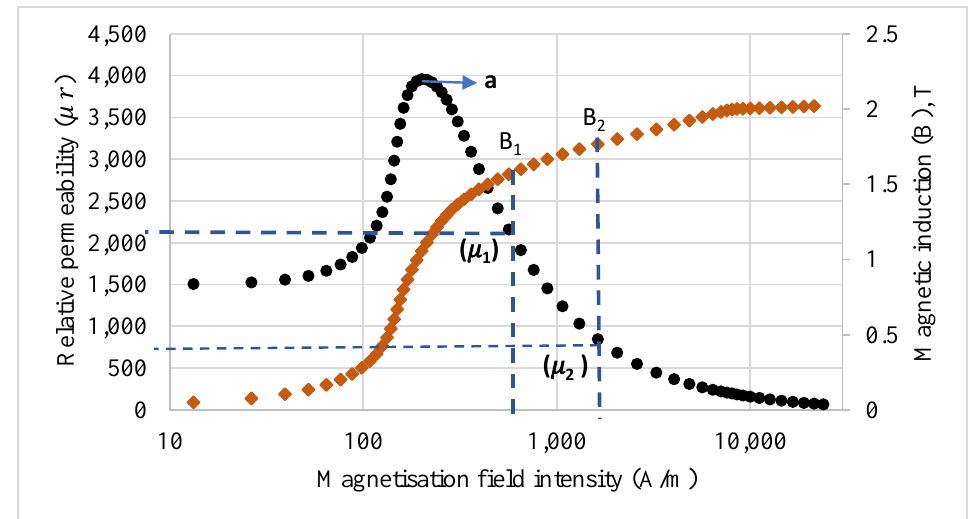
Figure 1. Magnetization and relative permeability as a function of applied field.